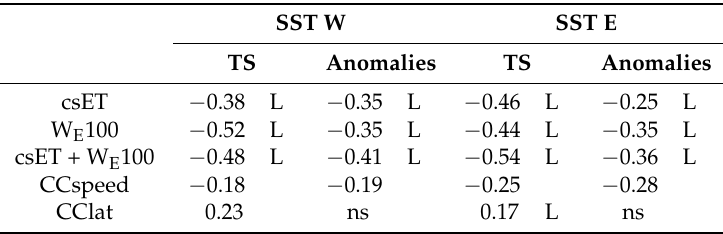
Table 2. Correlation between sea surface temperature (SST) and different upwelling forcing parameters. Correlation coefficients ( r ) are shown for analysis with time series values (TS), and with time series deseasonalized anomalies (calculated as the observed weekly value minus the weekly climatology). The best r between the nonlagged and lagged (L, SST lagged one week after the forcing mechanism) correlation is shown; other lags did not yield better correlations. Correlations were significant at p < 0.01 (ns: no significant). SST W SST